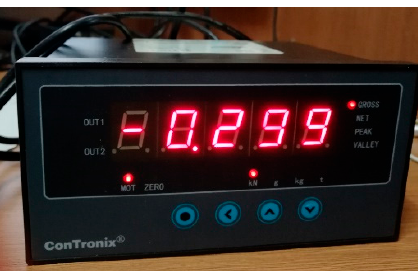
Figure 2. Icing box .